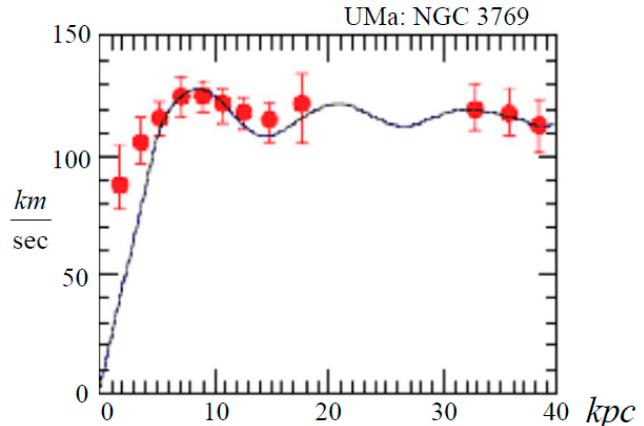
Figure 11. Rotation curve of the spiral galaxy NGC 3769 in the Ursa Major cluster. The vertical axis is the speed in km/sec. The horizontal axis is the distance from the center of the galaxy in kiloparsecs. The solid line is fitting by Equation (67).